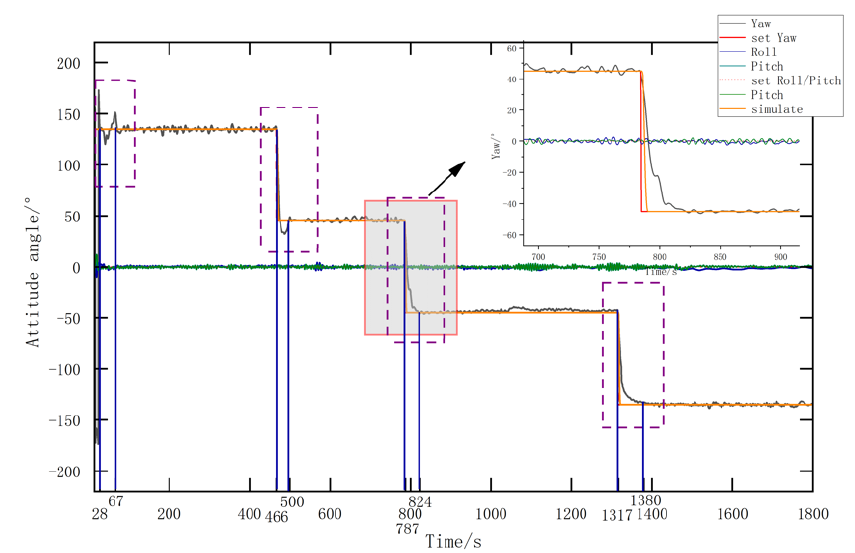
Figure 18. Depth control result in hovering mode.